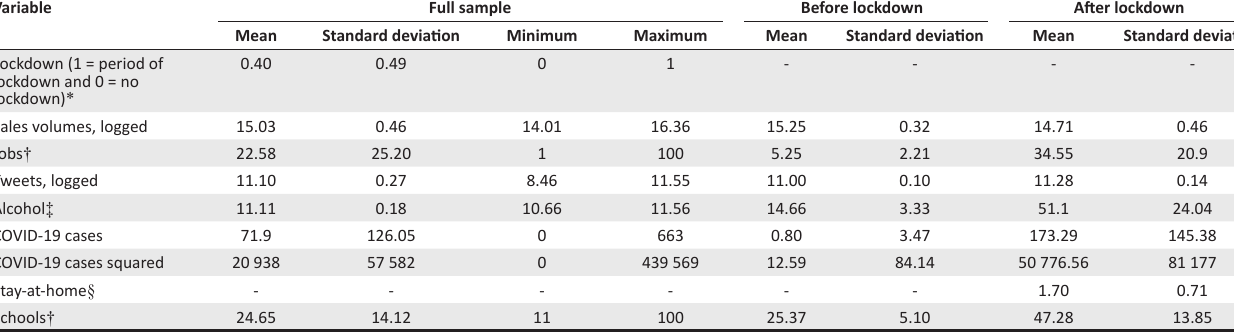
TABLE 1: Descriptive statistics of the variables included in the estimations of happiness. Variable Full